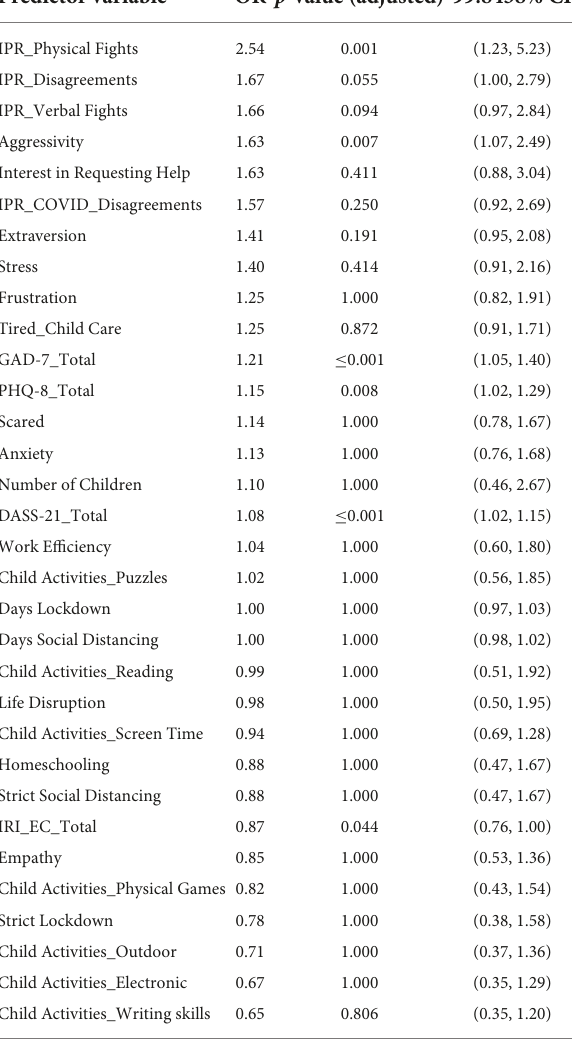
TABLE 2 (Time 3): Predictors of verbal aggression toward children in the unregularized regression model. Predictor variable OR p -value (adjusted) 99.8438% CI